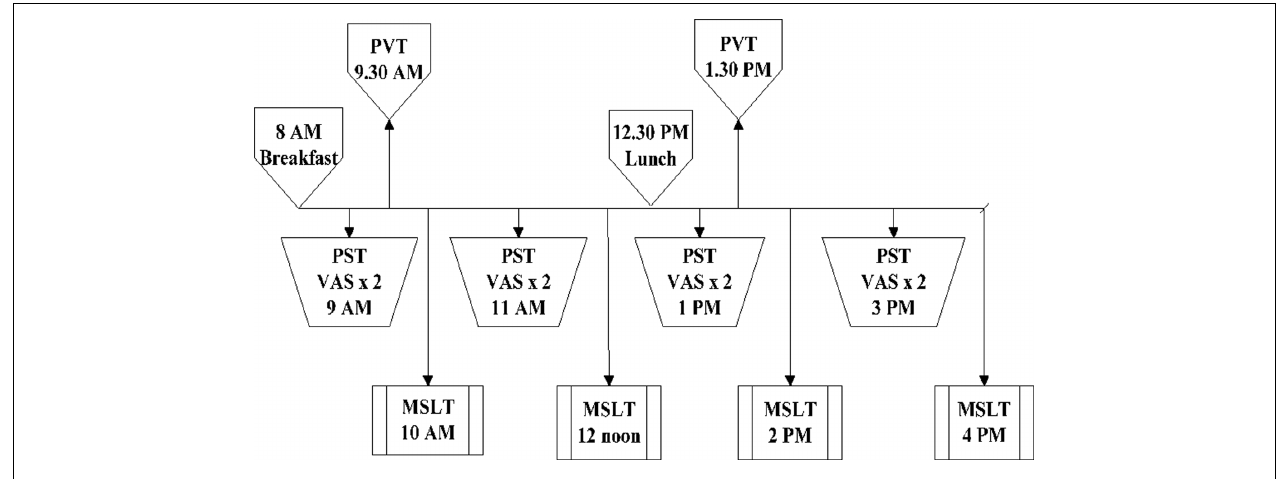
FIGURE 1 | Protocol for daytime tests.